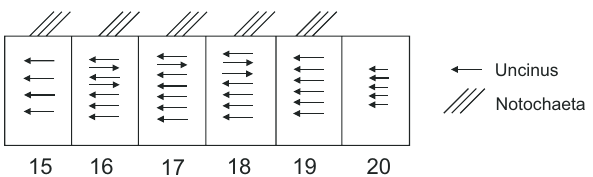
Figure 7. Nicolea uspiana : Inverted position of uncini in a “double” row on segments 15 to 18, and a single row of uncini on segment 19. Numbers indicate the sequence of segments